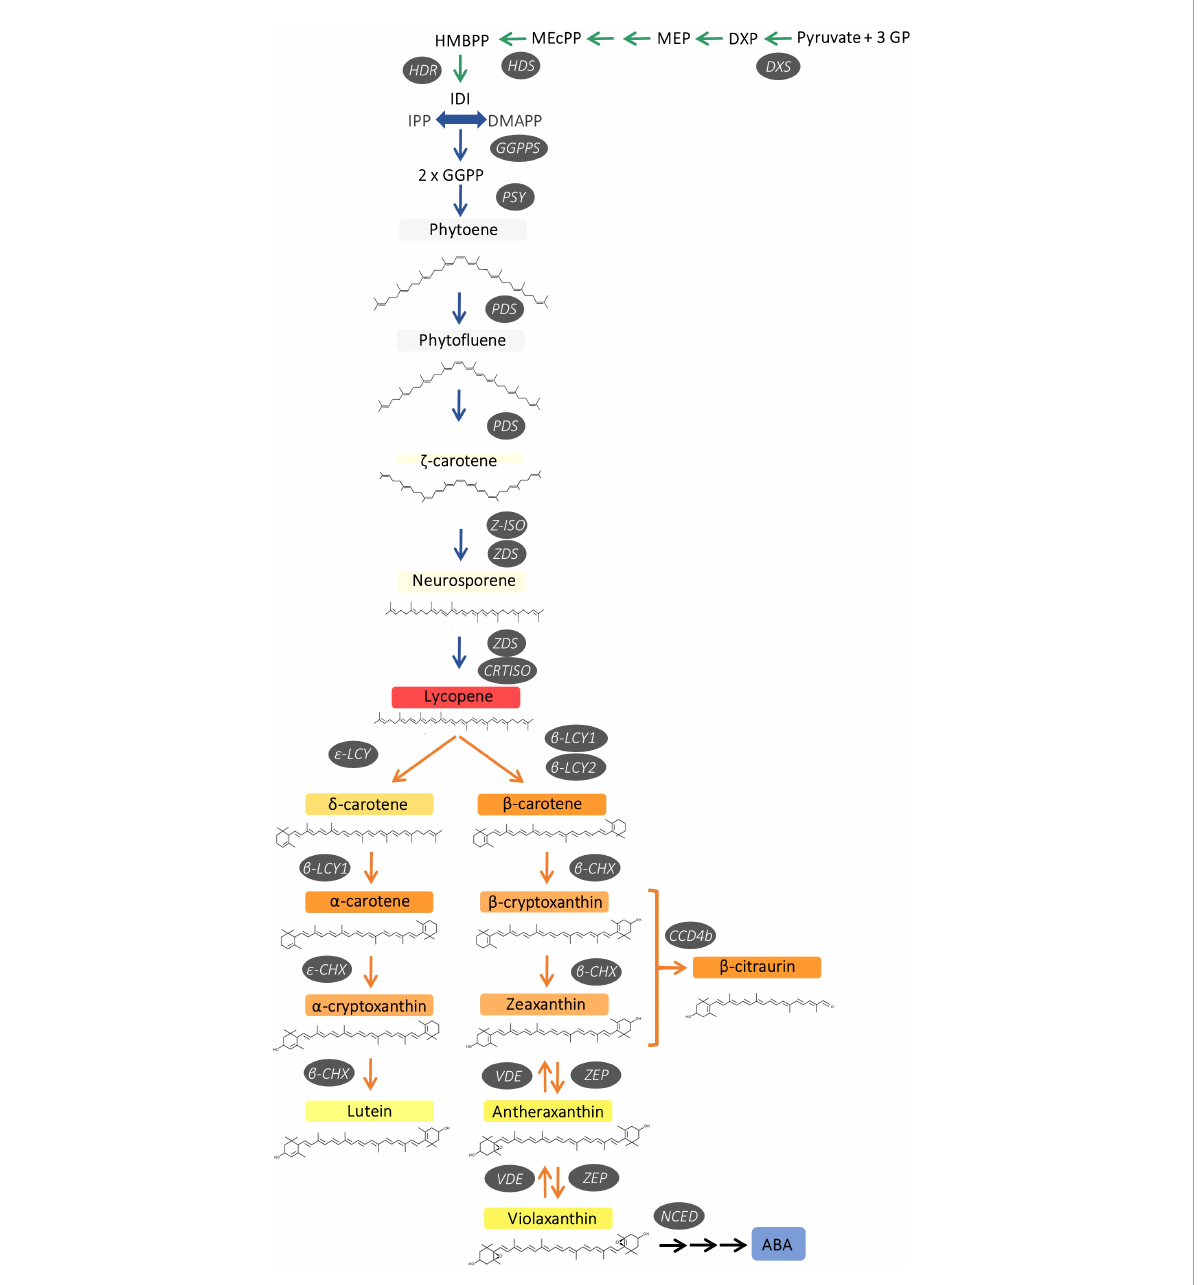
FIGURE 1 Schematic representation of carotenoid biosynthesis in citrus fruits, indicating main enzymes and genes of the pathway. 1-deoxy-D-xylulose-5- phosphate synthase ( DXS ), hydroxymethylbutenyl diphosphate synthase ( HDS ) and reductase (HDR ), geranylgeranyl diphosphate synthase ( GGPPS ), phytoene synthase ( PSY ), phytoene desaturase ( PDS ), z -carotene isomerase ( Z-ISO ), z -carotene desaturase ( ZDS ), carotene isomerase ( CRTISO ), ϵ -lycopene cyclase ( ϵ -LCY), b -lycopene cyclase ( b -LCY1/2 ), ϵ -carotene hydroxylase ( ϵ -CHX ), b -carotene hydroxylase ( b -CHX ), carotenoid cleavage dioxygenase 4b ( CCD4b ), zeaxanthin epoxidase ( ZEP ), violaxanthin de-epoxidase ( VDE ) and 9-cis-epoxy-carotenoid dioxygenase ( NCED